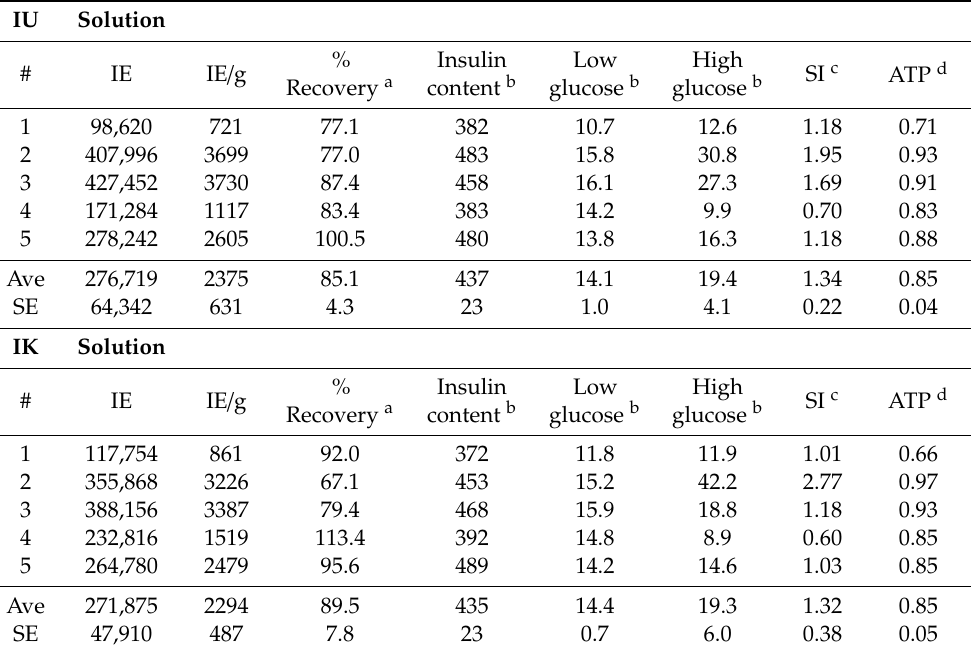
Table 3. Characteristics of islets after purification.